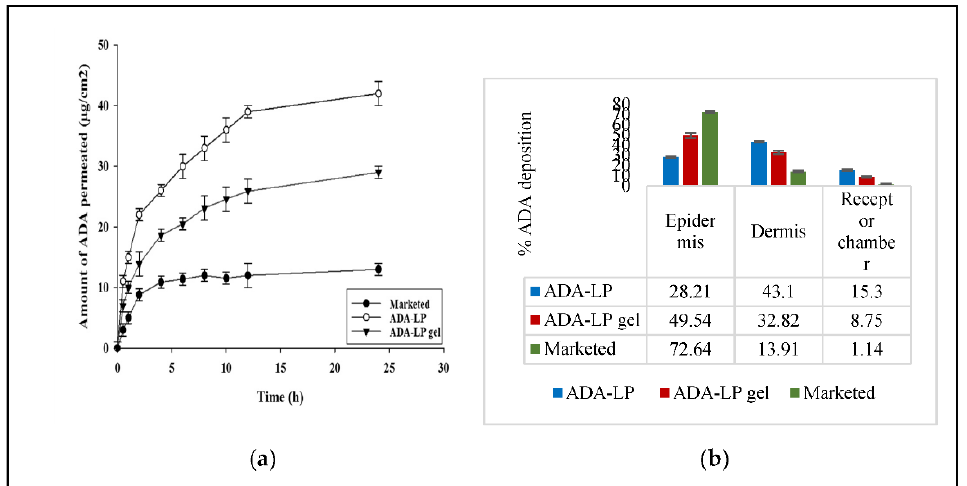
Figure 7. ( a ) Ex vivo permeability of ADA-LP, ADA-LP gel, and marketed gel where p = <0.05 and ( b ) Drug deposition study in different skin layers .